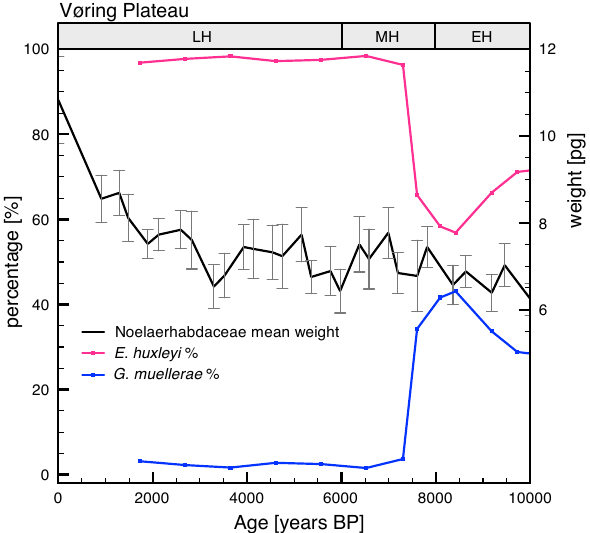
Fig. 7. Relative abundance of Noelaerhabdaceae species at Vøring Plateau from sediment core GIK 23071 over the Holocene (An- druleit, 1995): E. huxleyi (red line), G. muellerae (blue line), in comparison to the Noelaerhabdaceae mean coccolith weight (black line).